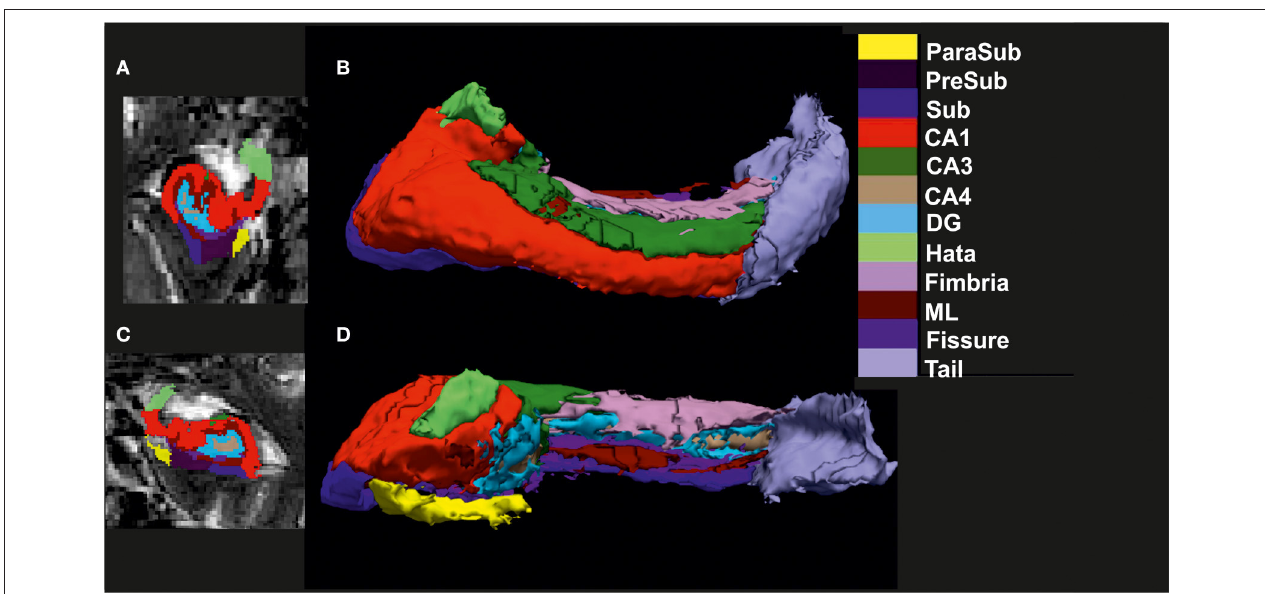
FIGURE 1 | Visualization of hippocampal subfield segmentation. (A) Left hippocampal subfields (HippSub) presented in a coronal MRI section, (B) Left HippSub illustrated in a 3D reconstruction, (C) Right HippSub presented in a coronal MRI section, and (D) Right HippSub illustrated in a 3D reconstruction. HippSub color code is on the right side of the figure. CA1/3/4, cornu ammonis 1/3/4; DG, granule cell layer-molecular layer of the dentate gyrus; Hata, hippocampus-amygdala transition area; ML, molecular layer; ParaSub, Parasubiculum; PreSub, Presubiculum; Sub, Subiculum.